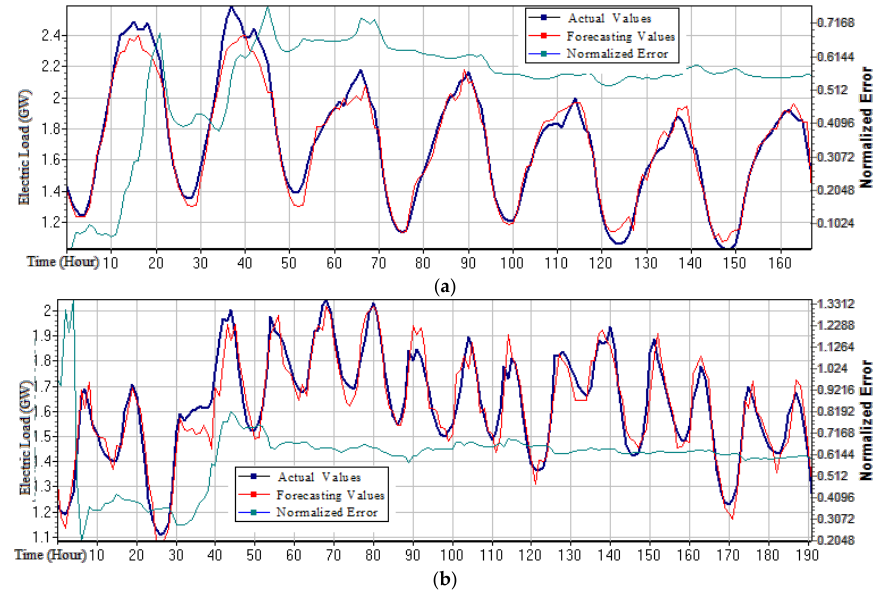
Figure 7. Forecasting results for ( a ) a week in summer and ( b ) a week in